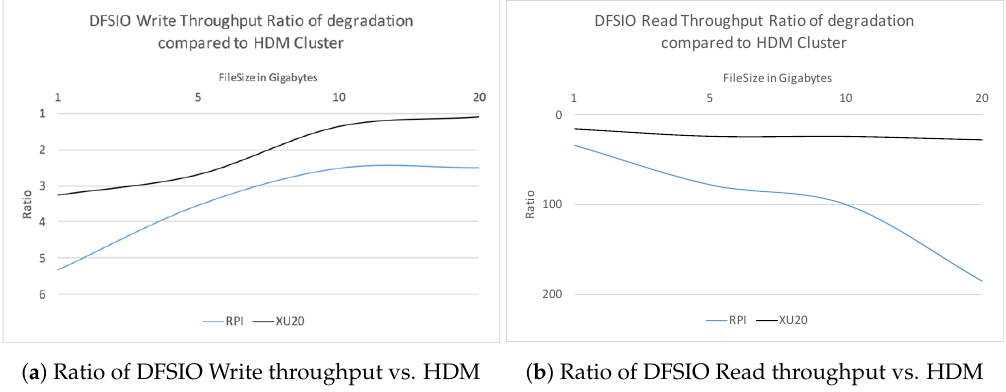
Figure 5. TestDFSIO read/write